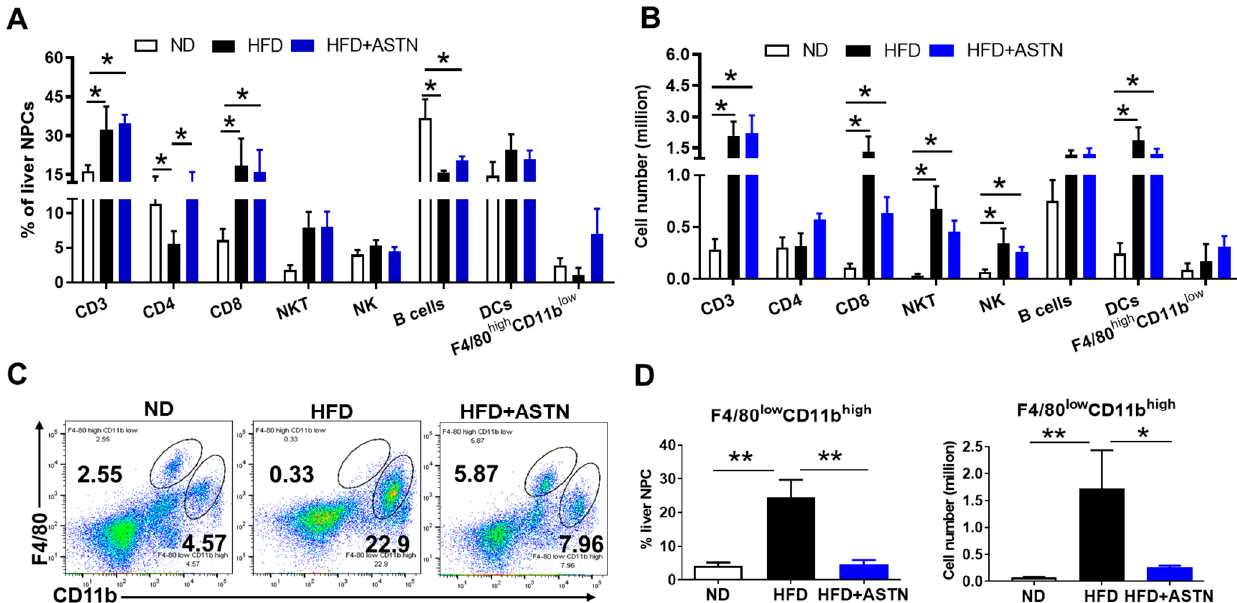
Figure 5. Astaxanthin treatment modulates the intrahepatic immune response. Liver non-parenchymal cells (NPCs) consisting of most CD45 + cells were isolated from ND, HFD, and HFD + ASTN-treated mice, and were stained with fluorochrome-conjugated antibodies. Flow cytometry was applied to analyze the components of immune cells in the livers. ( A ) The frequency of different types of immune cells in the liver. Flow cytometry was applied to define the frequency of different types of immune cells including CD3 (CD3 + ), CD4 (CD4 + CD3 + ), CD8 (CD8 + CD3 + ), NK (CD49b + CD3 ‒ ), NKT (NK1.1 + CD3 + ), DCs (CD11c + CD11b + ), B cells (CD3 ‒ B220 + ), and liver macrophages including F4/80 high CD11b low Kupffer cells and F4/80 low CD11b high monocytes-derived macrophages. ( B ) The absolute cell number of each lymphocyte shown in ( A ). ( C ) Representative frequency of liver macrophages in NPCs. ( D ) Mean frequency (left) and absolute number (right) of F4/80 low CD11b high monocytes-derived macrophages in NPCs in three groups of mice with the indicated treatments. n = 5, error bars represent the mean ± SD. Statistical analysis of data was performed by one-way ANOVA using GraphPad Prism 8 software. ** p < 0.01, * p < 0.05.